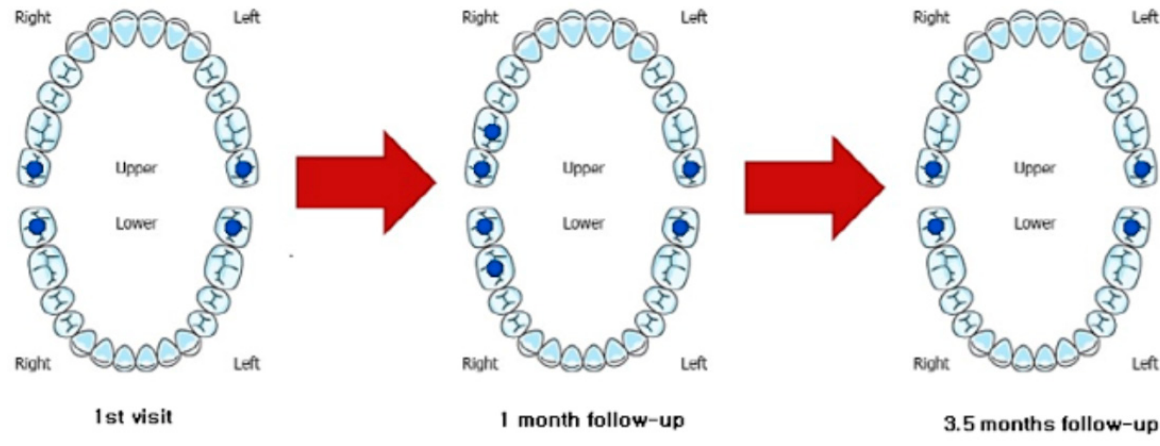
Figure 6. Occlusion